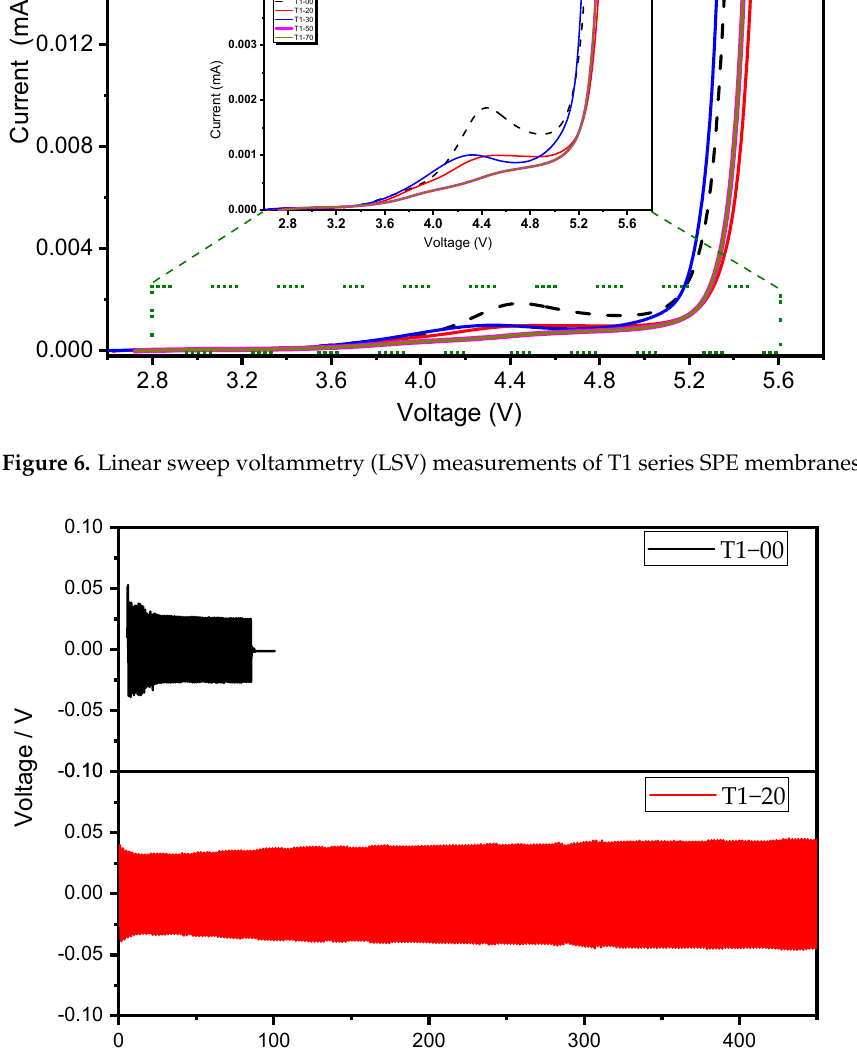
Figure 7. Strip-plate tests on Li°|SPE|Li° symmetric cells employing T1-00 and T1-20 at 80 °C.